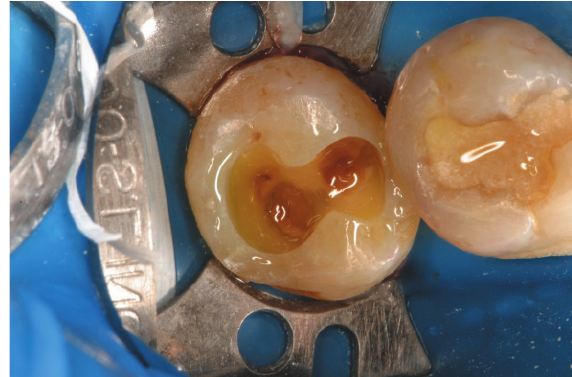
Figure 14- A yellowish appearance indicates that all